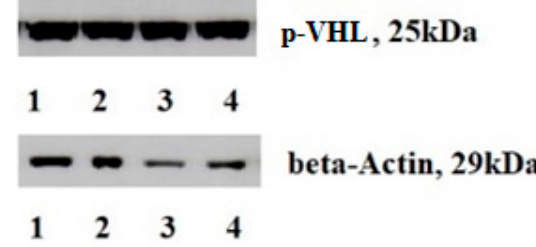
2, 4—non-transformed tissues; p-VHL content is a key oncogenic event in ccRCC development. It promotes and triggers the main biological processes resulting in metabolism modification, im- mune regulation, apoptosis, and cell movement.